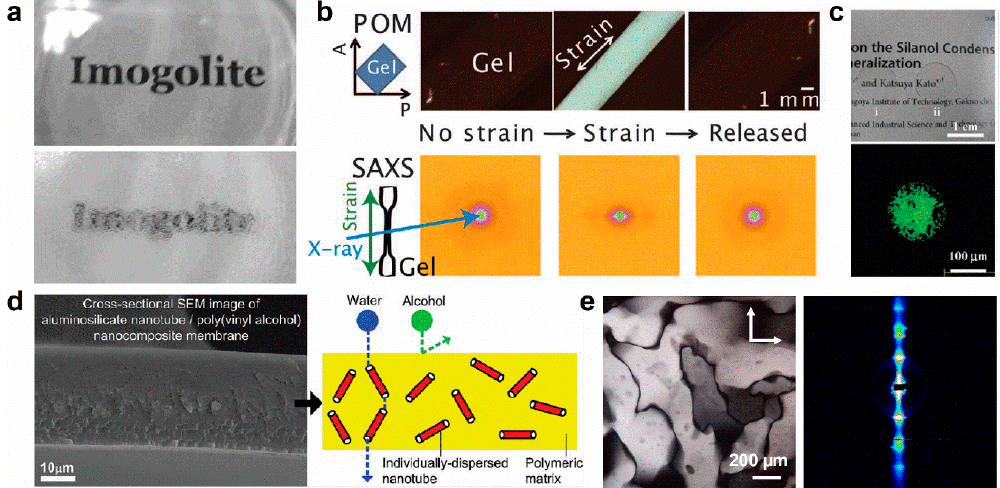
Table 3. Type of polymer used for nanocomposites preparation with